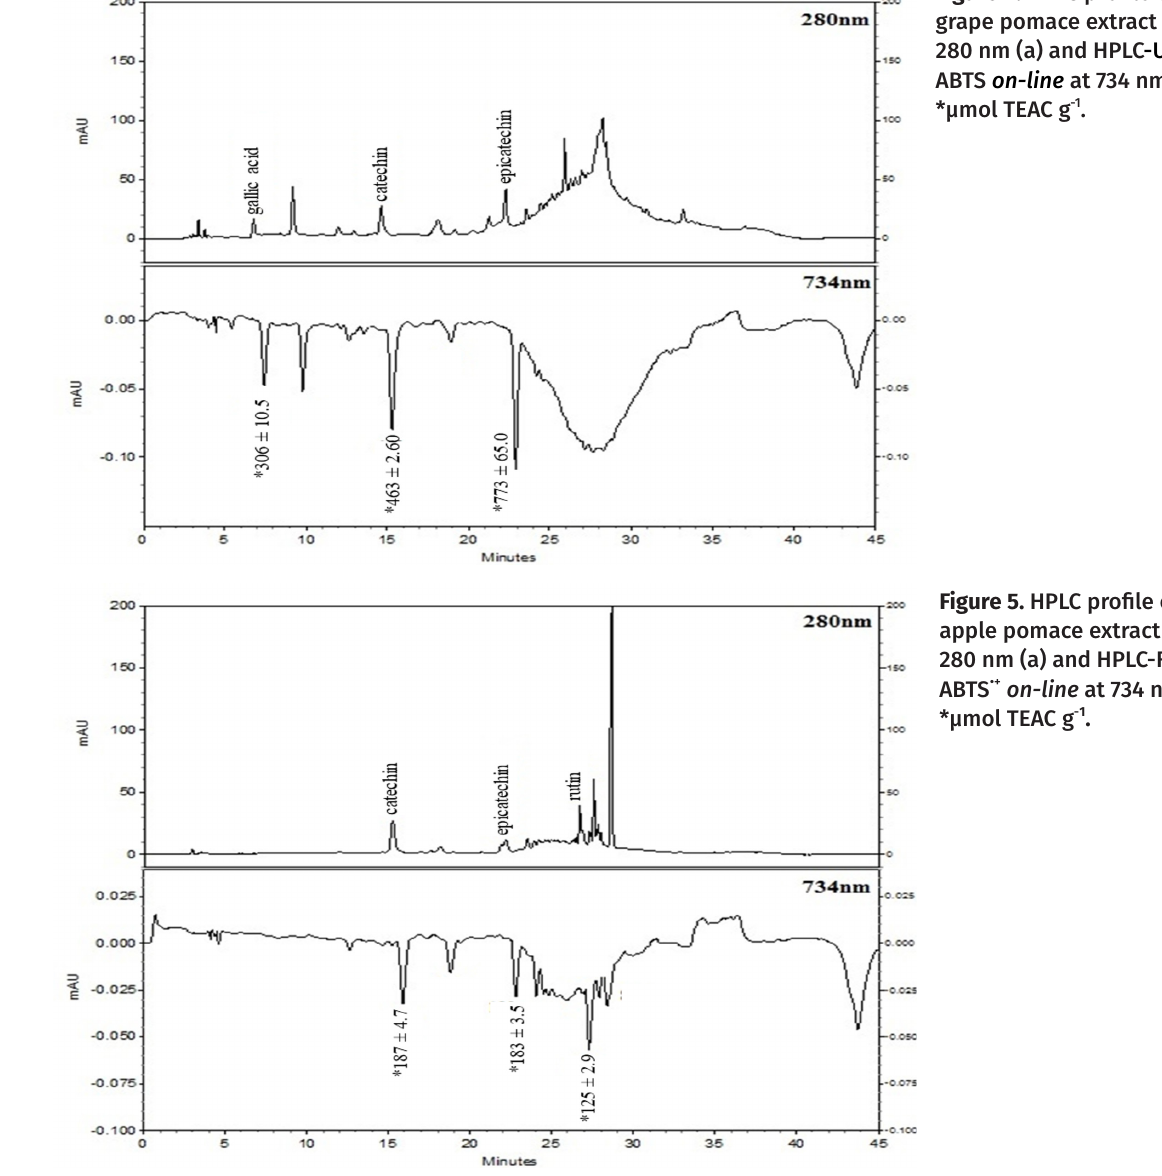
Figure 4. HPLC profile of grape pomace extract at 280 nm (a) and HPLC-UV- ABTS on-line at 734 nm (b). *µmol TEAC g -1 .